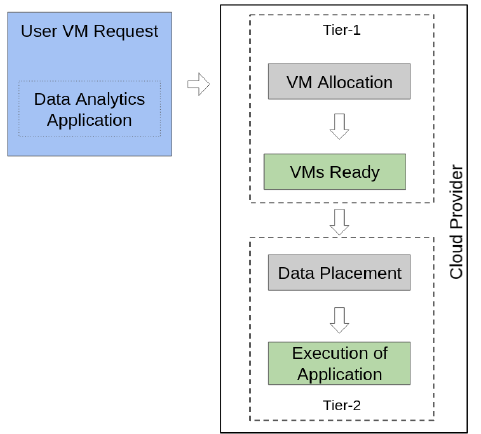
Figure 1. Workflow for virtual machines resource allocation and data